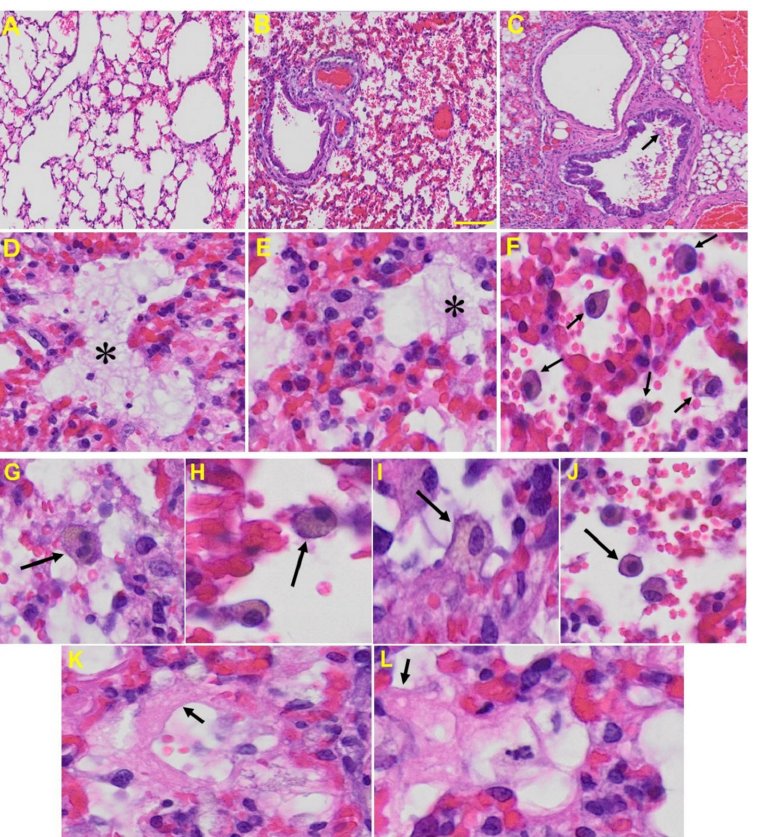
Figure 5. Lung from MHV-1 exposed mice. ( A ) Normal mouse. ( B ) MHV-1-infected mouse lung at day 7. ( C ) The MHV-1 infected mouse lung shows inflammation, granular degeneration of cells, and migration of leukocytes into the lungs (arrow). ( D , E ) Proteinaceous debris filling of the alveolar spaces with fibrillar to granular eosinophilic protein strands caused by progressive breakdown of the capillary wall and epithelial integrity, permitting the leakage of protein-rich edema fluid into the alveoli (asterisk) (commonly seen in ARDS). ( F – J ) Presence of hemosiderin-laden macrophages, indicating pulmonary congestion with dilated capillaries and leakage of blood into alveolar spaces. Further, peribronchiolar interstitial infiltration, bronchiole epithelial cell necrosis, necrotic cell debris within alveolar lumens, alveolar exudation, infiltration, hyaline membrane formation ( K , L ), and alveolar hemorrhage with red blood cells within the alveolar space and interstitial edema were also observed in these mice (H&E original magnification 400 × Figure 5A–C; scale bar image divided by actual scale bar